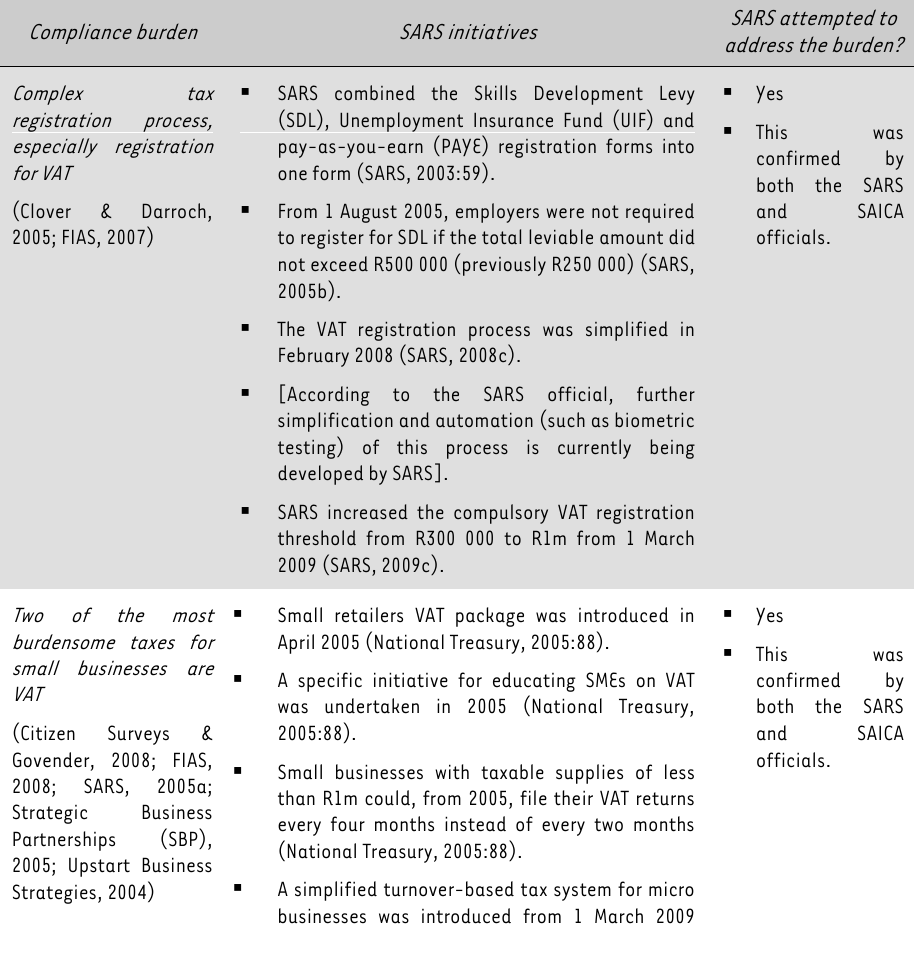
Comparison of the tax compliance burdens to SARS’s initiatives Compliance